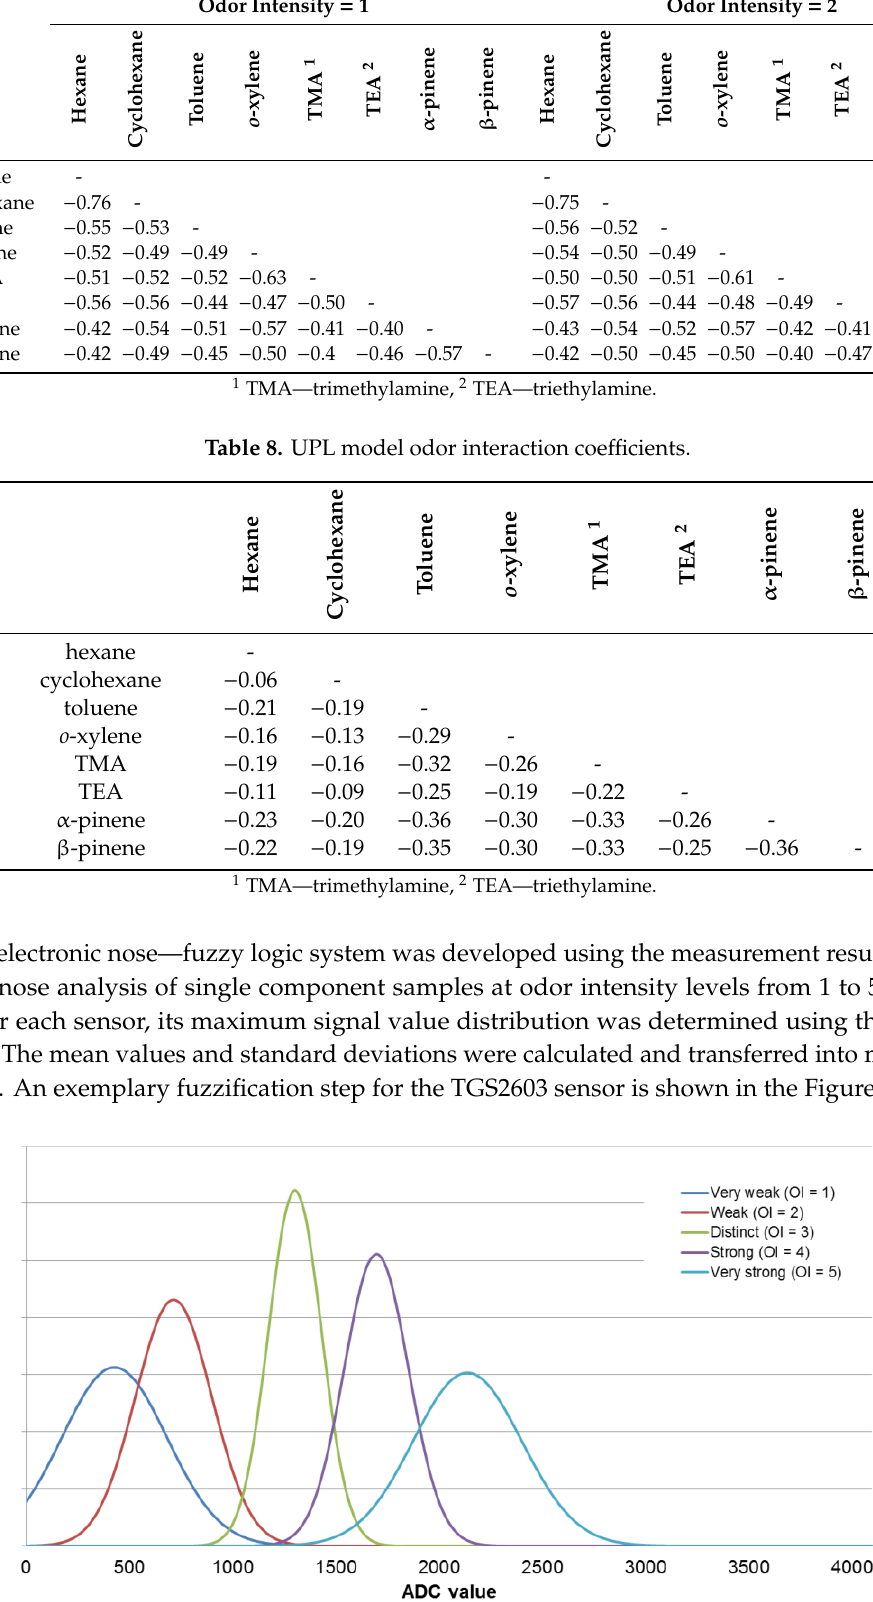
Figure 6. Proposed fuzzy logic algorithm validation plot. For comparison of the theoretical models, sensory analysis, and values obtained using the electronic nose and fuzzy logic, 28 binary mixtures were generated in such a way that the concentrations of the individual substances were equal to an odor intensity equal to 3 (e.g., 74.1 ppm α -pinene and 28.5 ppm β -pinene). The mixtures were investigated using the sensory panel and the electronic nose. Three replicates were made for each sample. The theoretical values were determined using the vectorial model (Equation (7)), Euclidean additivity model (Equation (9)), U model (Equation (10)), and UPL model. As an interaction factor, the mean values from Table 6; Table 7 were used. The comparison of the obtained is shown in Figure 7.